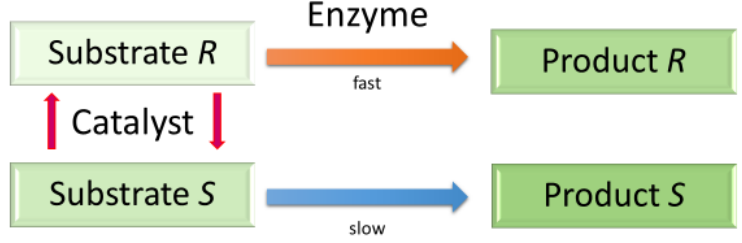
Figure 1. Dynamic kinetic resolution.